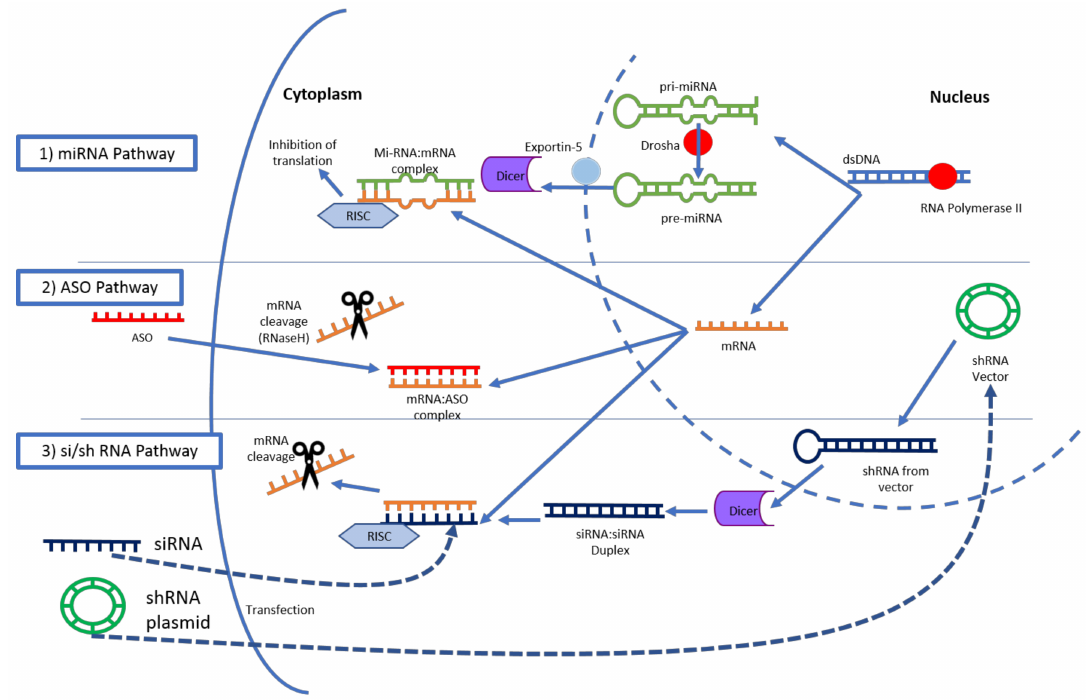
Figure 3. RNA Molecules and respective pathways. (1) miRNA pathway. After processing, one double-stranding miRNA associates with the RNA-induced silencing complex (RISC) complex and inhibits translational expression; (2) Antisense oligonucleotide (ASO) pathway. ASOs enter the cell cytoplasm via described mechanism, bind the target mRNA, and activate intracellular RNase enzyme; (3) siRNA pathway. dsRNA or shRNA are first altered by DICER and become mature siRNA. One strand of siRNA associates with the RISC complex and marks mRNA for